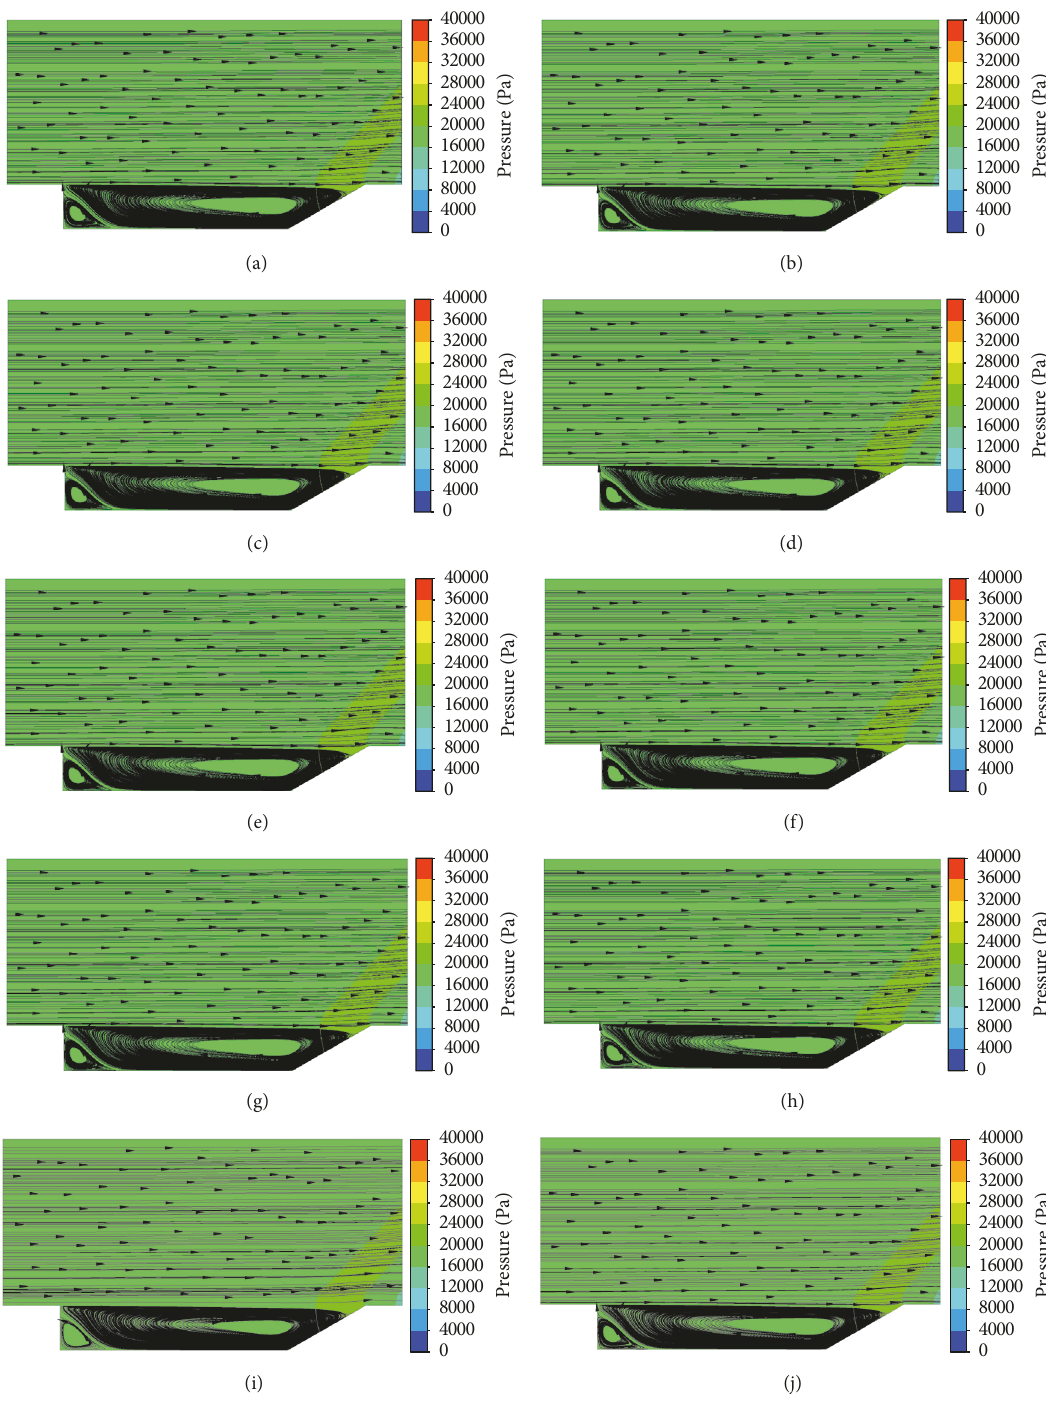
Figure 20: Pressure fluctuations of the whole domain (TWM3) (a) 𝑡/𝑡 𝑅 = 0 , (b) 𝑡/𝑡 𝑅 = 0.11 , (c) 𝑡/𝑡 𝑅 = 0.22 , (d) 𝑡/𝑡 𝑅 = 0.33 , (e) 𝑡/𝑡 𝑅 = 0.44 , (f) 𝑡/𝑡 𝑅 = 0.55 , (g) 𝑡/𝑡 𝑅 = 0.66 , (h) 𝑡/𝑡 𝑅 = 0.77 , (i) 𝑡/𝑡 𝑅 = 0.88 , and (j) 𝑡/𝑡 𝑅 = 1 .